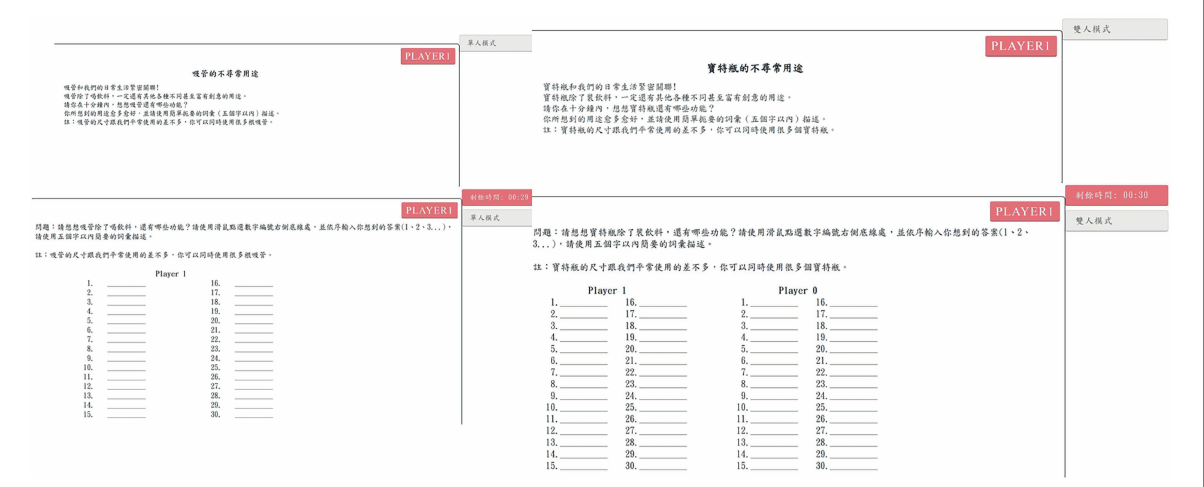
FIGURE 2 The user guide page and answering page of the interactive creativity task platform.